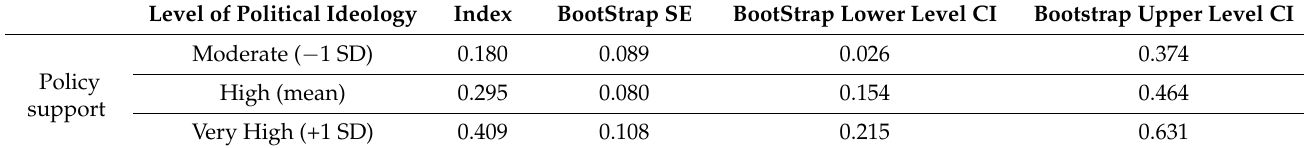
Table 1. Conditional Indirect Effects of Credibility on Outcome Variables.